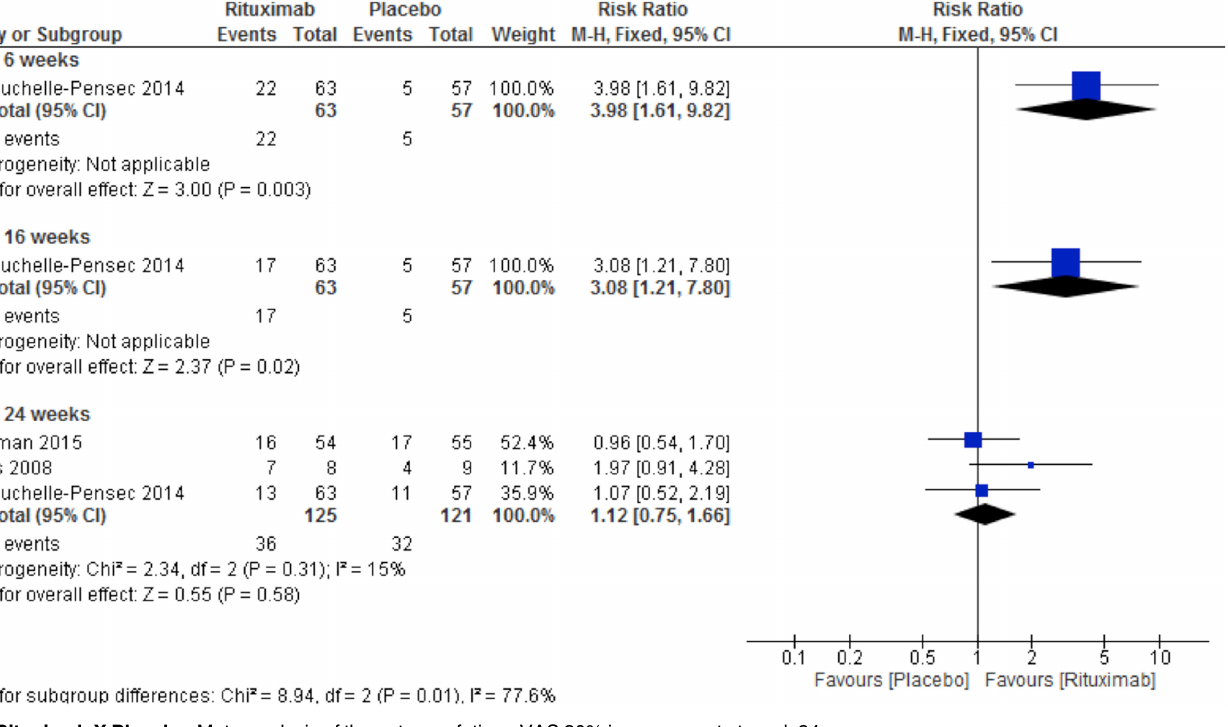
PLOS ONE | DOI:10.1371/journal.pone.0150749 March 21,